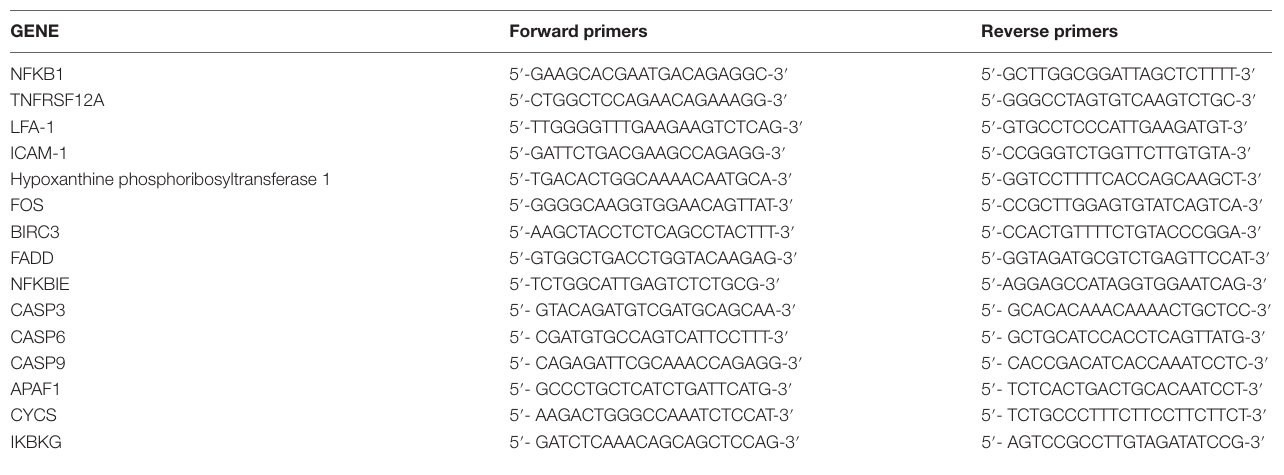
TaBle 1 | Primer sequences for quantitative RT-PCR. gene Forward primers reverse